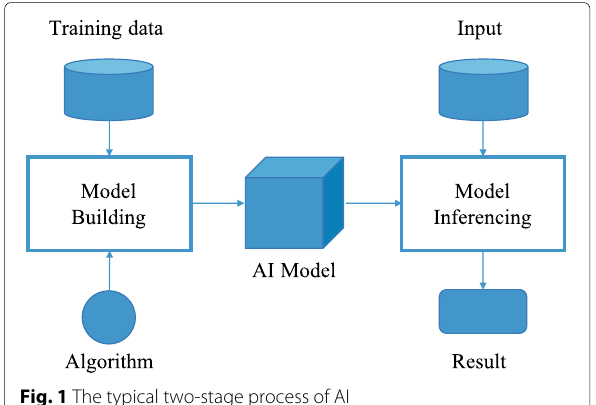
Fig. 1 The typical two-stage process of AI